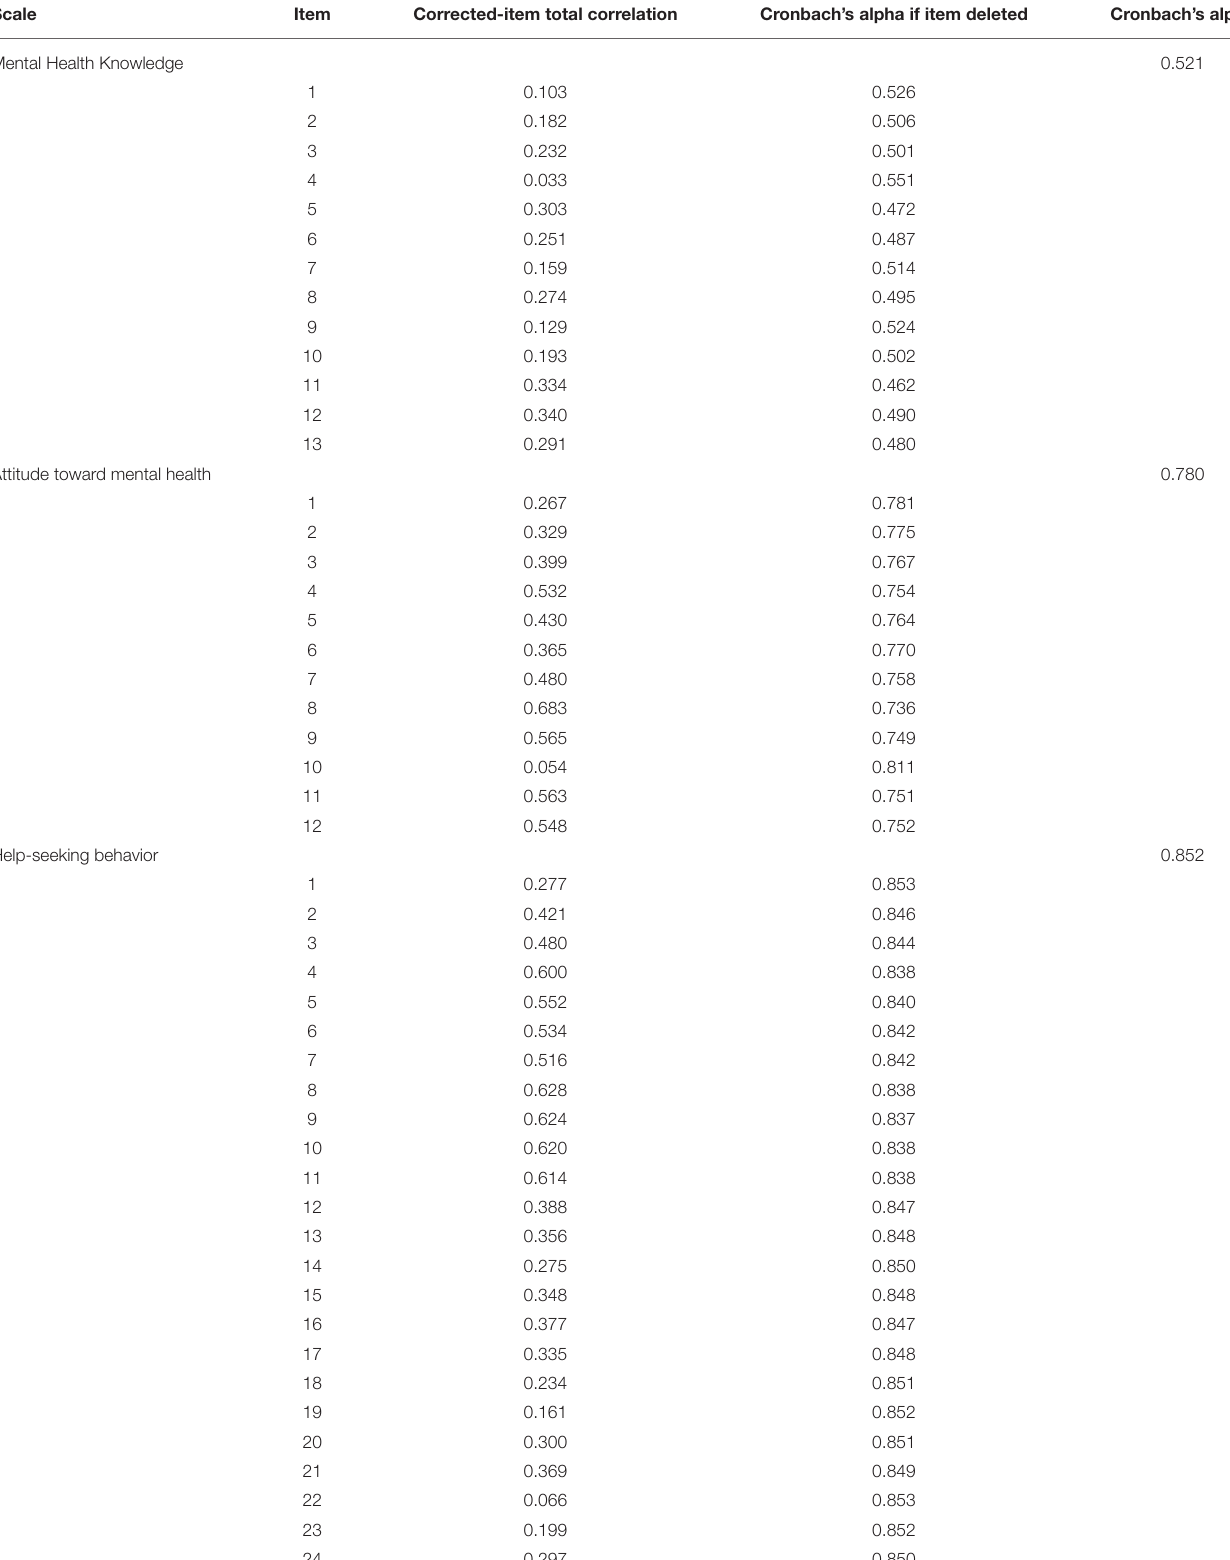
TABLE 4 | Internal consistency of the Indonesian mental health literacy and help-seeking behavior set of questionnaires.